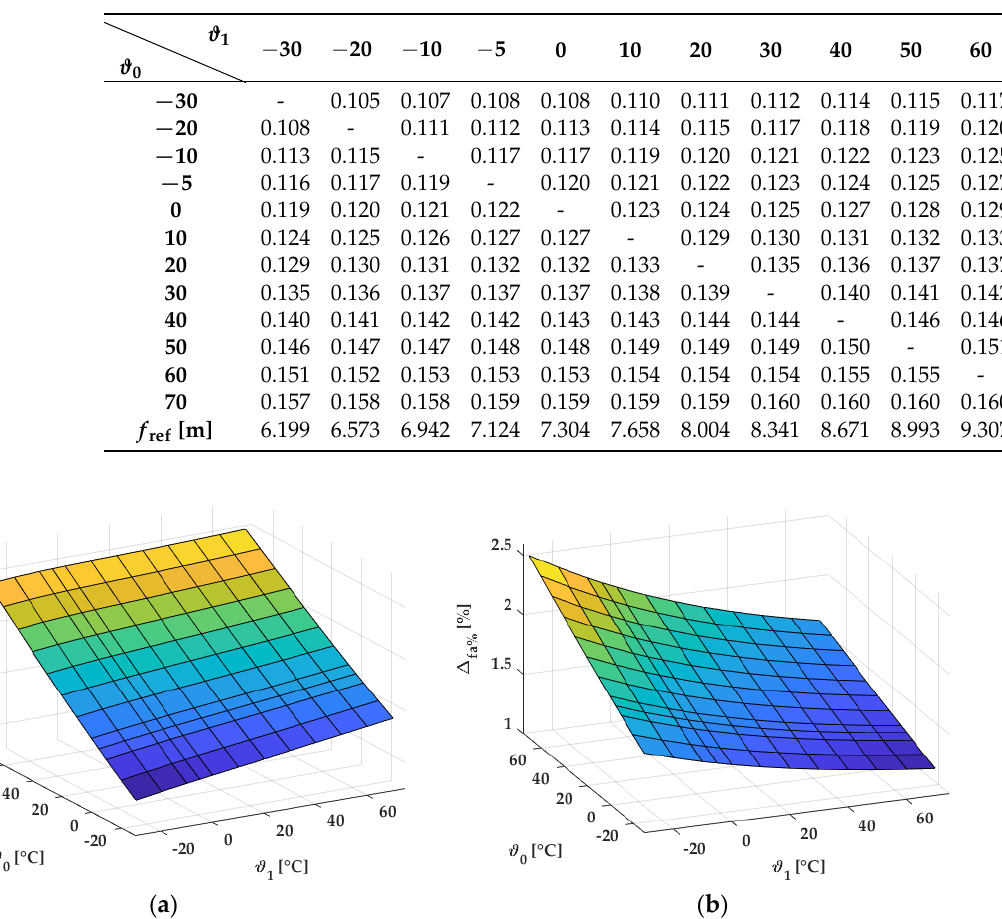
Table 8. Maximum absolute sag deviations ∆ fa [m] caused by the incorrect determination of the tower span by − 2.5 m.